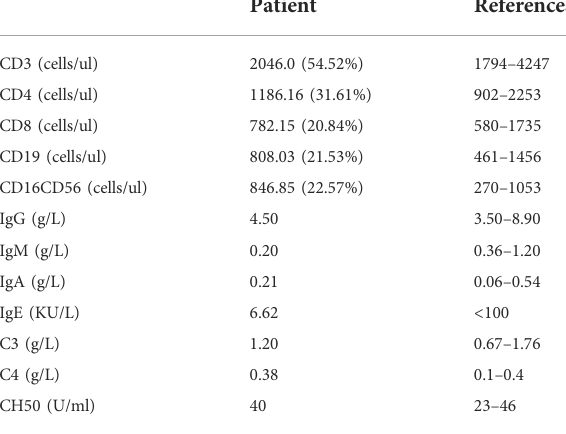
TABLE 1 Distribution of the lymphocyte subsets and immunoglobulin in the patient.